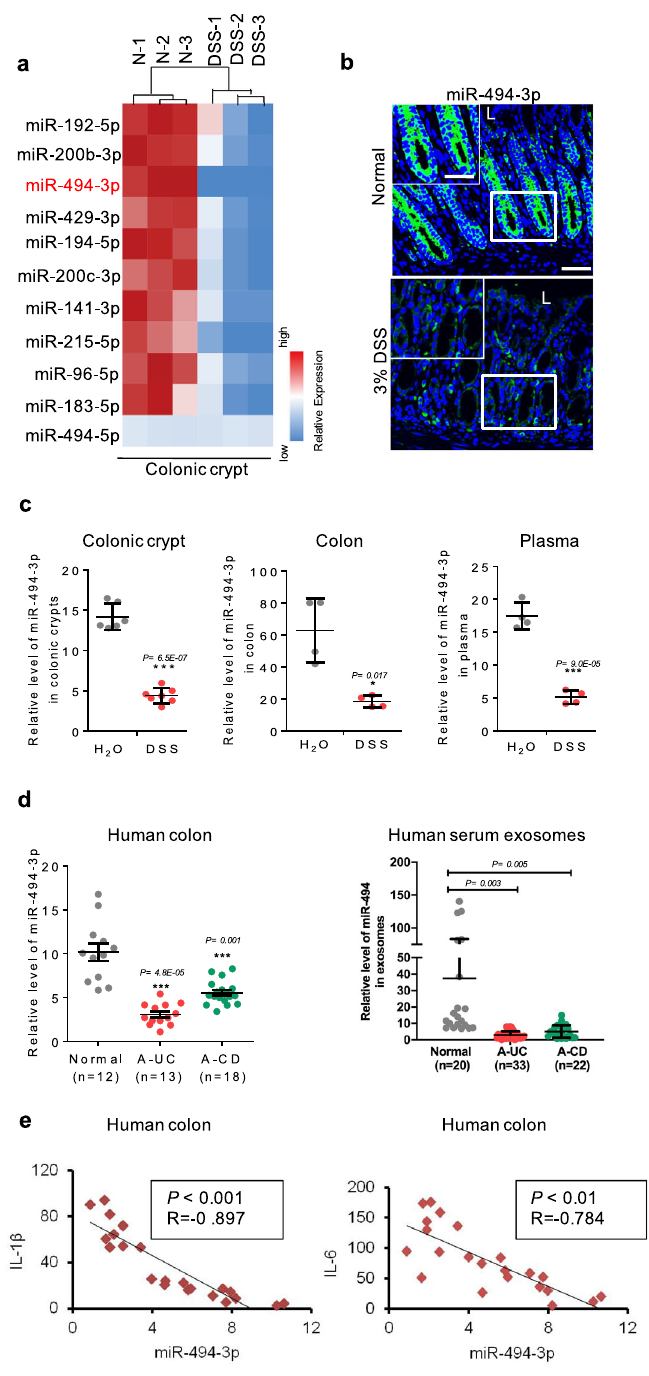
Fig. 1 miR-494-3p de fi ciency relates to colitis. a – c C57BL/6 mice (male, 8-week-old) were divided into two groups and provided with drinking water neat (Normal, N) or drinking water with 3% DSS (DSS) for 7 days. a At day 7, colon crypts were isolated and RNAs were subjected to miRNome analysis. Heat map represented miRs signi fi cantly decreased, with ≥ 2-fold differences and P < 0.05 between control group (N) and DSS-treated group (DSS). The color in the heat map is linear with blue as the lowest and red as the highest. b miR-494-3p expression and location in colon tissues from RNA-FISH assays, scale bar: 50 μ m, scale bar of close-up image: 30 μ m. c The levels of miR-494-3p in colonic crypts (left), colonic tissues (middle) and plasma (right) were measured by qRT-PCR (normalized by U6 in colon tissue and colonic crypts, normalized by cel-miR-39 in plasma). d The levels of miR-494-3p in human colon tissues (left, normalized by U6) and exosomes extracted from human peripheral blood (right, normalized by cel-miR-39). Normal, healthy subject; A- UC, active ulcerative colitis; A-CD, active Crohn ’ s disease. e The plot showed the relationship between miR-494-3p level and IL-1 β (left) level or IL-6 (right) level in colon tissues from patients with active IBD (UC and CD). Data are presented as mean ± S.D. and analyzed by non-paired two-tailed Student ’ s t- test in the graphs in ( c , d ). *** P ≤ 0.001, ** P ≤ 0.01, * P ≤ 0.05.